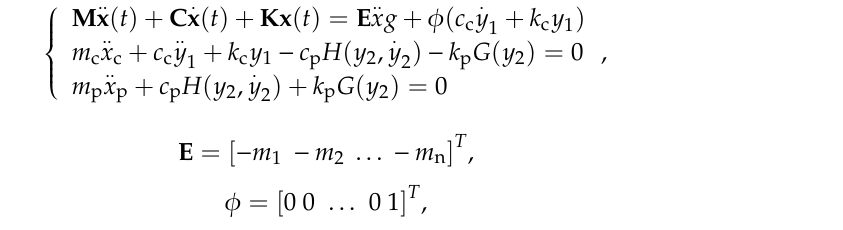
14 of 20 Figure 14. Experimental and simulation acceleration time histories in the linear structural system: ( a )